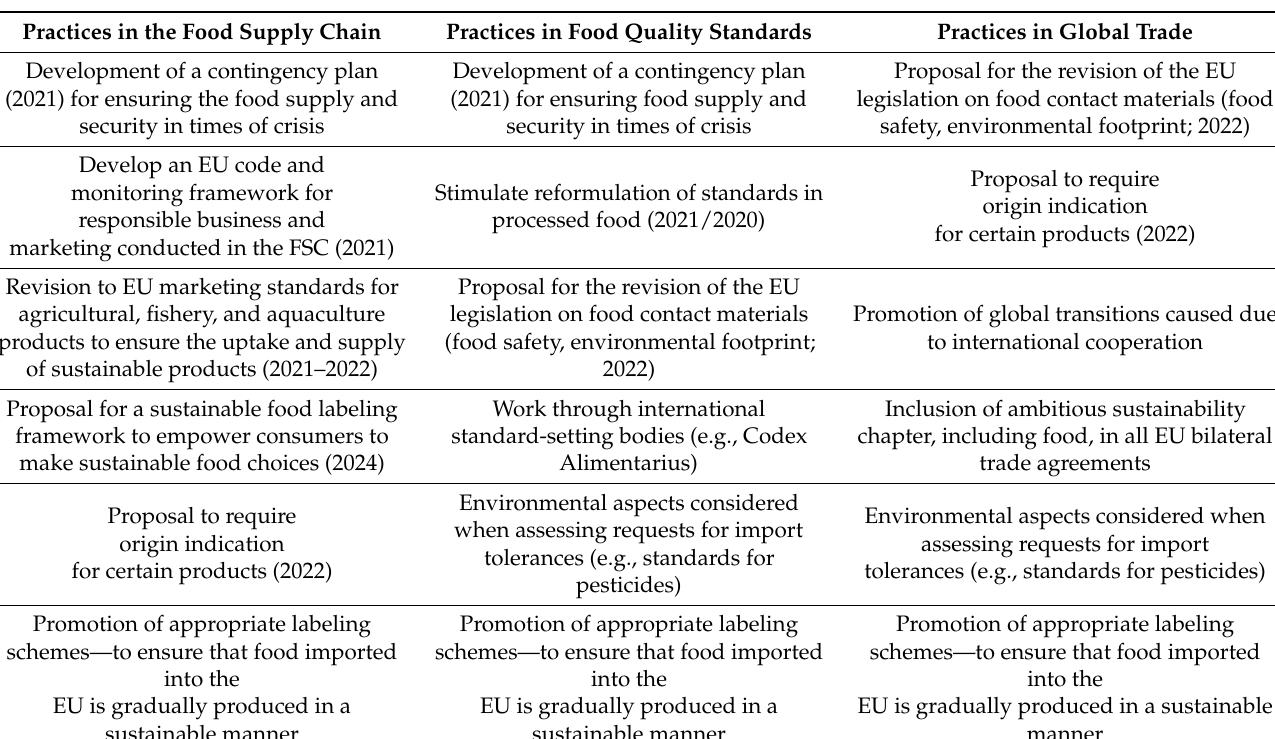
Table 1. Initiatives to stimulate sustainable practices, divided into the three main research aspects. Practices in the Food Supply